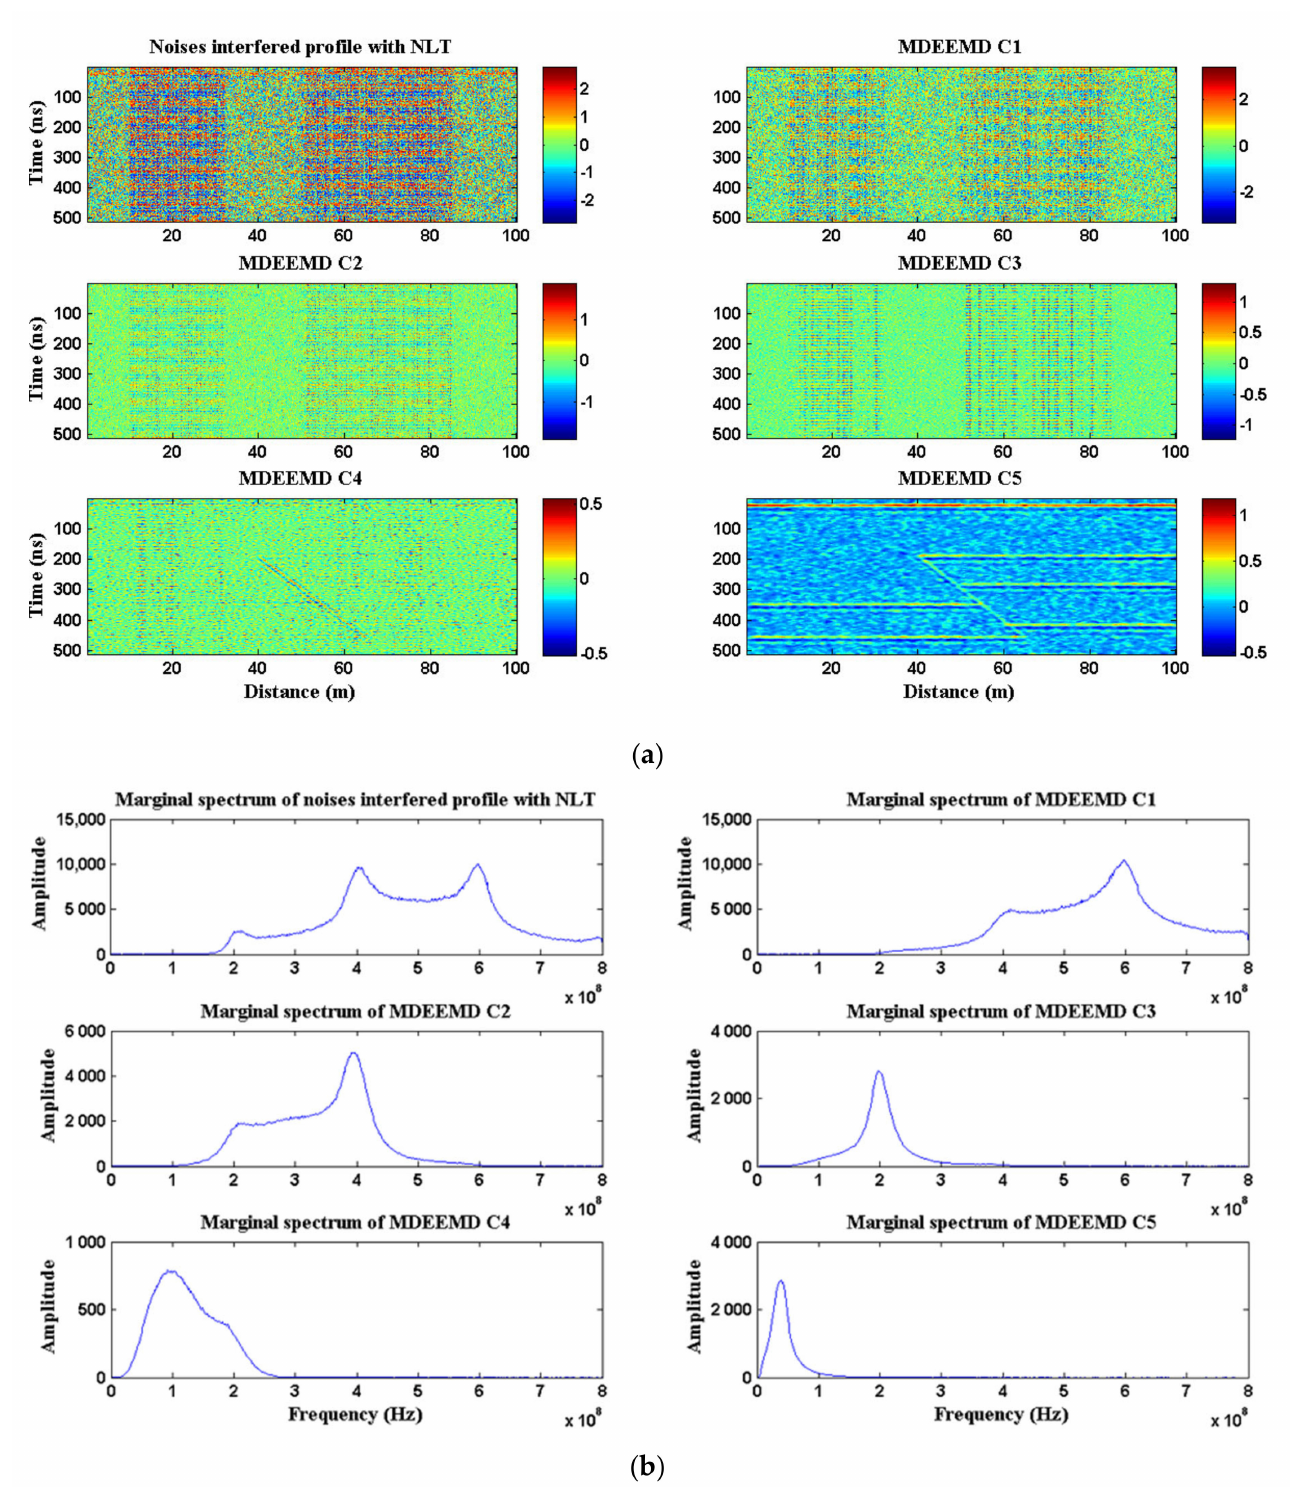
Figure 3. MDEEMD components and marginal spectra of the hypothetical model. ( a ) Decomposed components of the noise-corrupted profile shown in Figure 2f. ( b ) Marginal spectra for